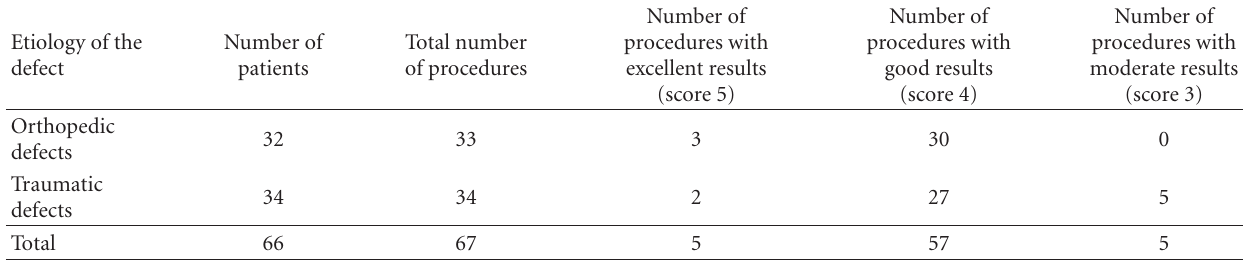
Table 2: Final results according to the etiology of the bone defects. The number of patients and procedures and the final scores given to patients with orthopaedic and traumatic defects are described. All procedures performed in orthopaedic defects presented good or excellent results. Defects caused by trauma are more suitable to show moderate results.